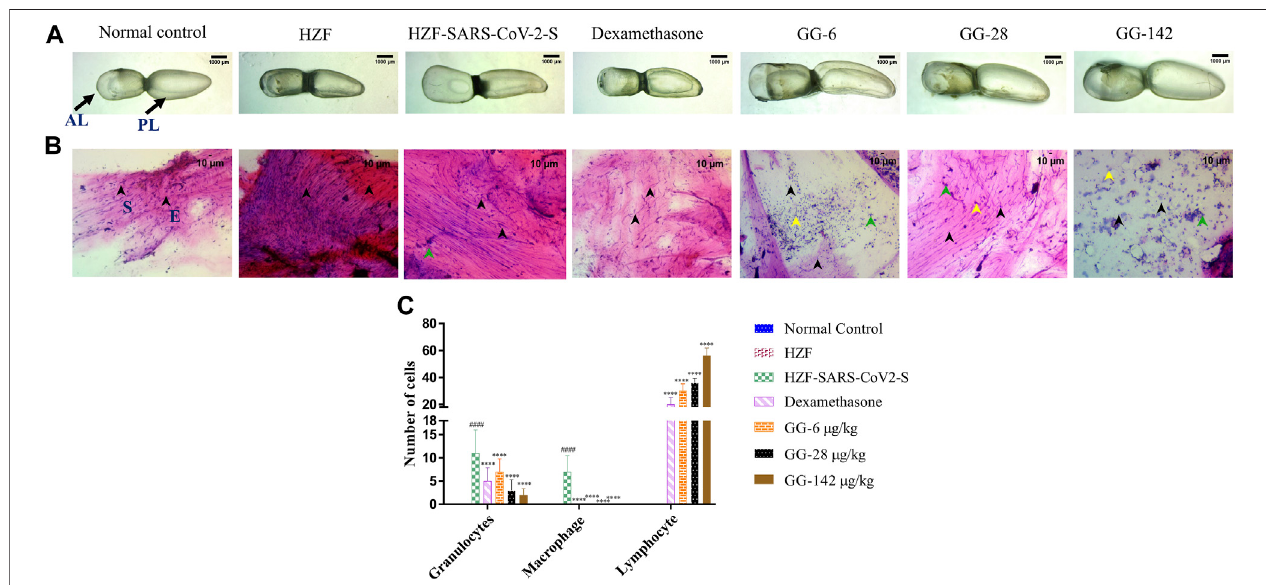
FIGURE 3 | 4-days time point to determine changes in morphology, cytology, and immune cell in fi ltration in the swim bladder. (A) Morphological changes in swim bladderwithSARS-CoV-2spike-proteininduction,andtreatmentwithDexamethasoneandGiloyGhanvati(GG)atdifferentconcentrations(6,28,and142 μ g/kg/day)at the 4-days time point. Images depict lateral view with the anterior lobe (AL) and posterior lobe (PL) marked. Images were taken at × 1 magni fi cation. (B) . Hematoxylin- Eosin stained cytology smears of whole swim bladder. Images were captured at × 20 objective magni fi cation. Normal cell nuclei depicted by black arrowheads; E- Epithelialcells,andS-Smoothmusclecells.Greenarrowheadsshowgranulocytesandtheyellowarrowheadsshowlymphocytes. (C) Quantitativeestimationofimmune cellin fi ltratesintheswimbladder.Datapointsaredepictedasmean ± S.D.analyzed byTwo-Way ANOVAfollowedbyTukey ’ smultiplecomparisons test. n (cid:2) 24,(####) p < 0.0001 compared to normal control, (****) p < 0.0001 compared to disease